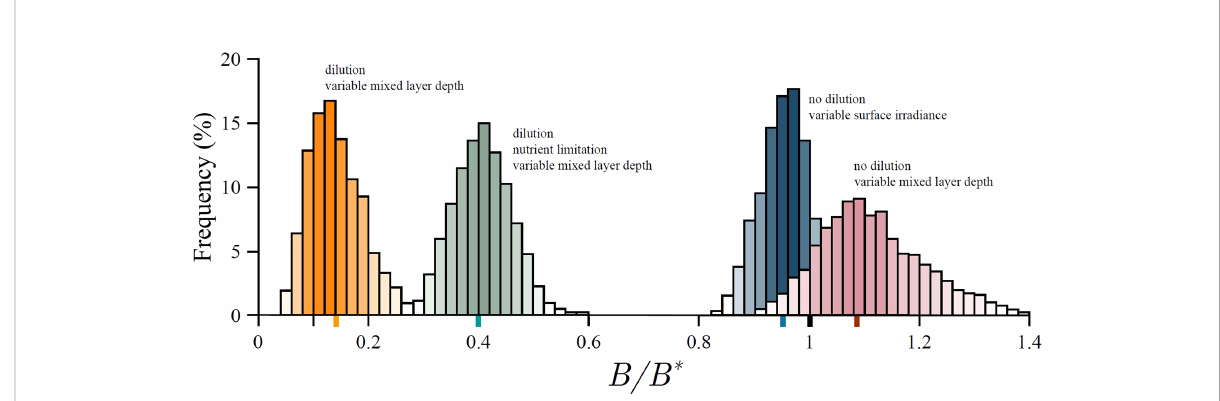
FIGURE 6 Distribution of the ratio of realized biomass B to the steady state biomass B ∗ for an example model run. Because of fragility biomass under variable surface irradiance (blue histogram) is on average lower (blue marker) than the steady state biomass under constant surface irradiance (black marker). In case of no dilution, and due to antifragility, biomass under variable mixed-layer depth (red histogram) is on average higher (red marker) than under constant mixed-layer depth (black marker). Taking dilution into account suppresses the biomass (orange histogram). However, taking dilution and nutrient limitation into account simultaneously raises the biomass from this suppressed state (green histogram). Average biomass for each scenario is given by the coloured marker on the abscissa. See Supplementary material for more information.